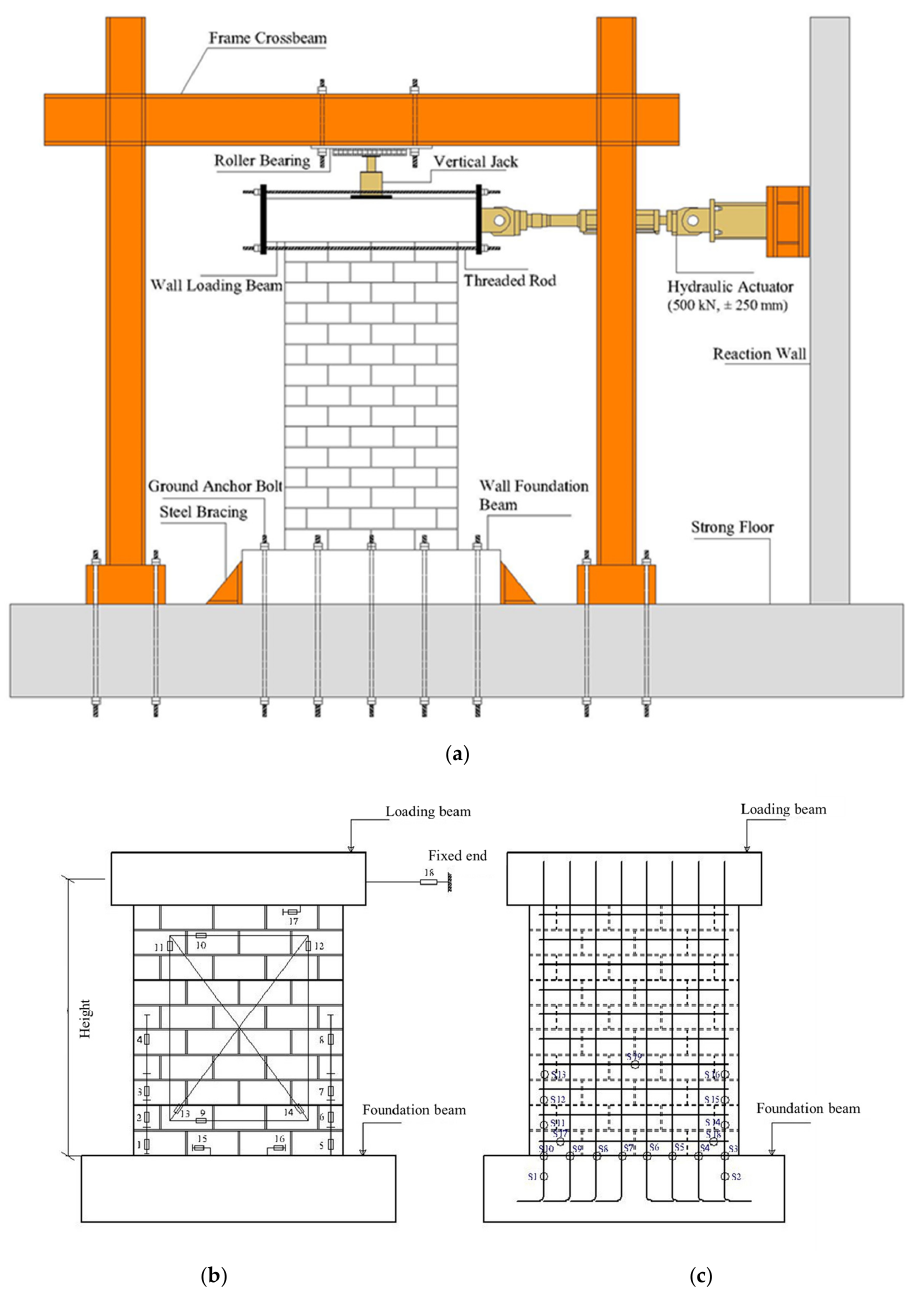
Figure 3. General test specimen details: ( a ) test setup; ( b ) external instrumentation; and ( c ) internal